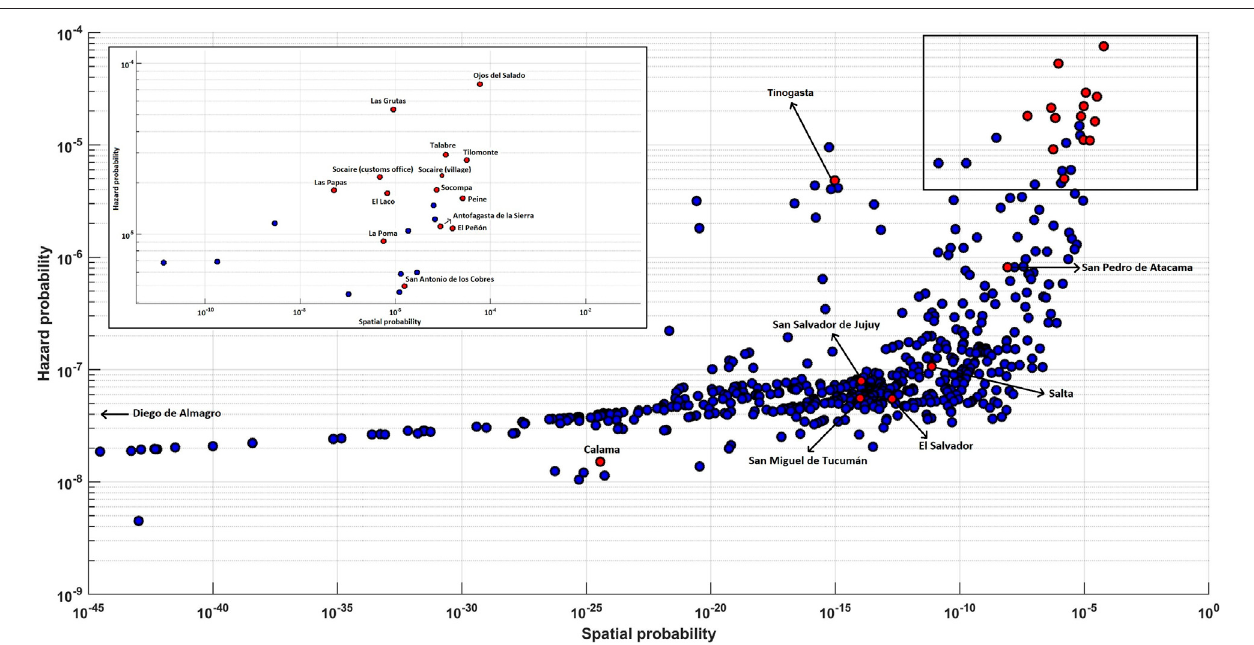
FIGURE8 | Probability ofa volcanic eventoccurringat any ofthe 692populated sites inthe study area over the next10 kyr (calculated using the spatial probability map shown in Figure 3A ), plotted against the probability that this same location be affected by any volcanic phenomenon over the same period (calculated using the integrated quantitative volcanic hazard map shown in Figure 7A ). Red dots highlight the ten highest-ranked settlements listed in Table 1 and all those mentioned in the text. The list with all the settlements can be found in Supplementary Material S6 .